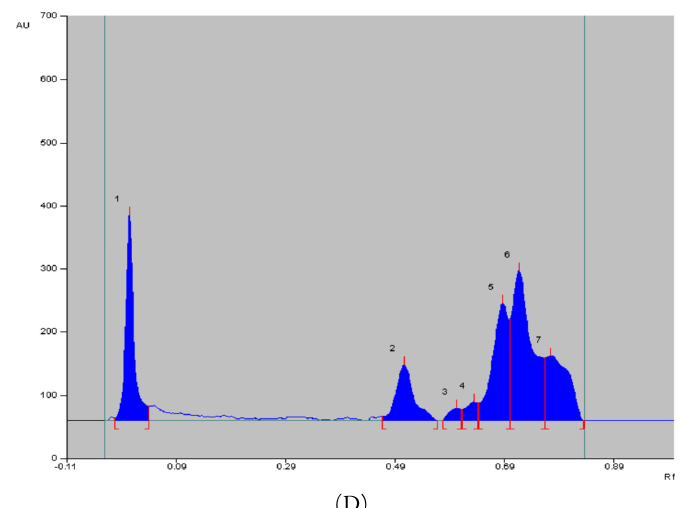
Figure 4. Densitogram of vasicine (A); Densitogram of vasicine from ethanolic extract (summer) (B); Densitogram of vasicine from ethanolic extract (rainy) (C); Densitogram of vasicine from ethanolic extract (winter) (D)